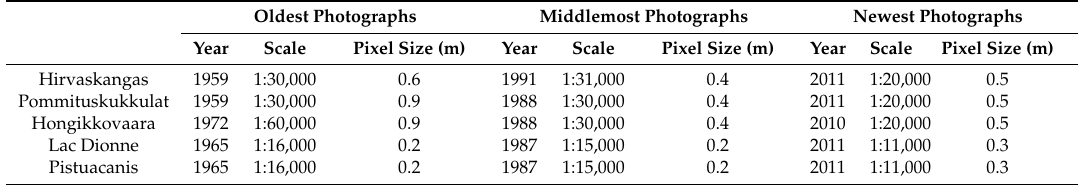
Table 1. The photographs used in the study. The Finnish aerial photographs are from the National Land Survey Finland, except for the 1972 photo in Hongikkovaara and 1991 photo in Hirvaskangas which are from the Finnish Defence Forces, and the middlemost photos in Pommituskukkulat and Hongikkovaara which are from Blom Geomatics AS. The newest Quebecois photographs are from Minist è re des For ê ts, de la Faune et des Parcs du Qu é bec, and the older photographs from Geomatheque Ltd., QC,